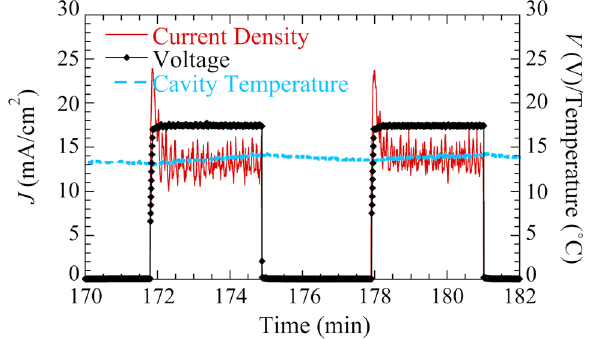
FIG. 19. Current, temperature, and voltage profiles in VEP of the nine-cell coupon cavity under a dual flow of acid and at a cathode rotation of 20 rpm.